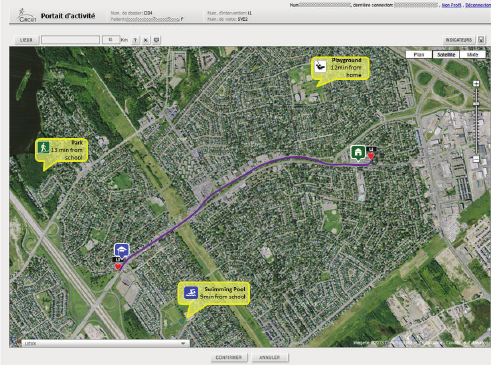
Figure 2: Interactive application for spatio-behavioural data visu- alization: GPS tracks, activity locations, and corresponding physical activity levels. NB: map indicates GPS tracks for one day automat- ically detected activity locations. Upper graph indicates physical activity levels during the day in relation to location (track). Lower graph shows time spent per physical activity level for each